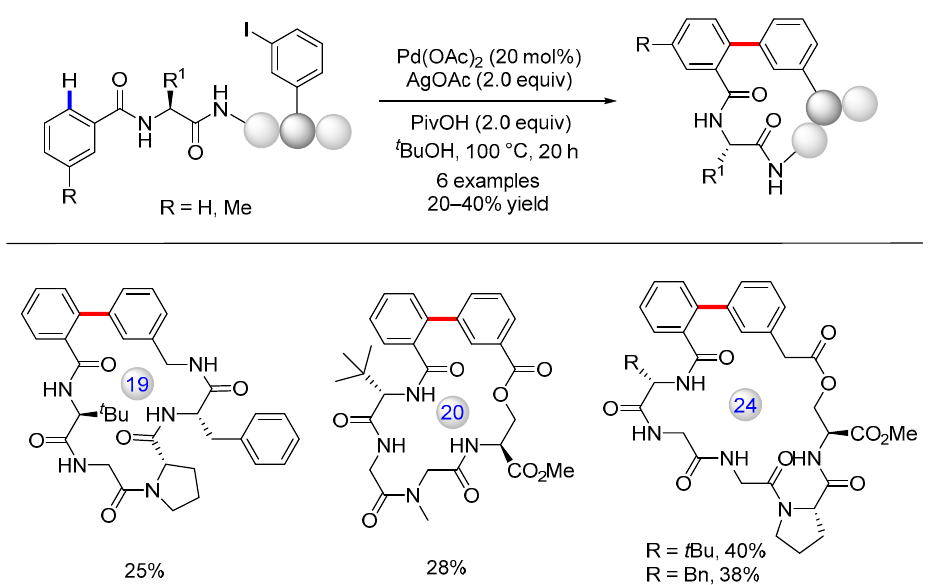
Figure 12. Macrocyclization of biaryl-bridged cyclic peptides via palladium-catalyzed intramolecular C(sp 2 )–H bond activation [71].